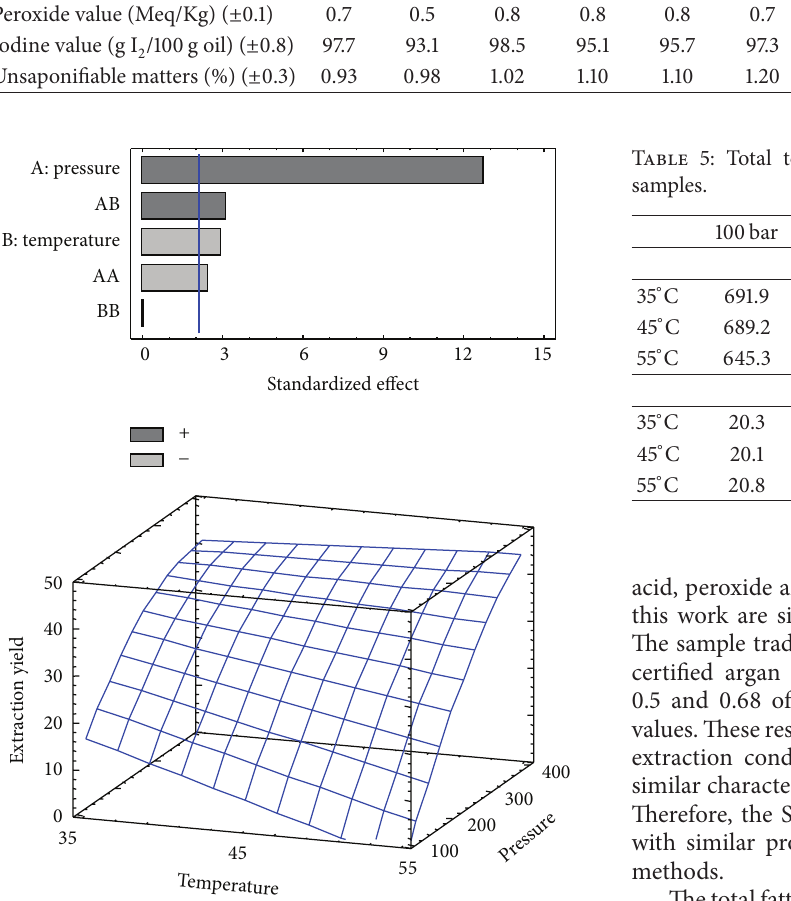
Figure 3: Pareto diagram and estimated extraction yields using empirical correlation (temperature ∘ C, pressure bar). Table 4: Fatty acid compositions of extracts obtained. Fatty acid